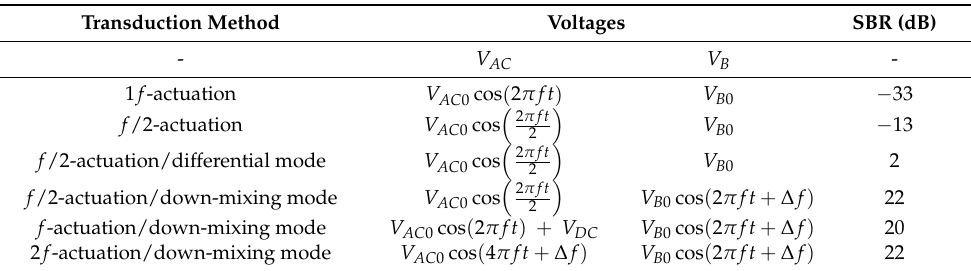
Table 2. Preliminary measurement of the signal-to-background ratio (SBR) for different transduction strategies (direct semitone, direct 1f, differential and down-mixed); V B 0 = 10 V , V DC = 10 V and f 0 = 1 MHz, ∆ f = 10 kHz; V AC 0 = 4.2 V for semitone actuation and V AC 0 = 0.5 V for 1 f